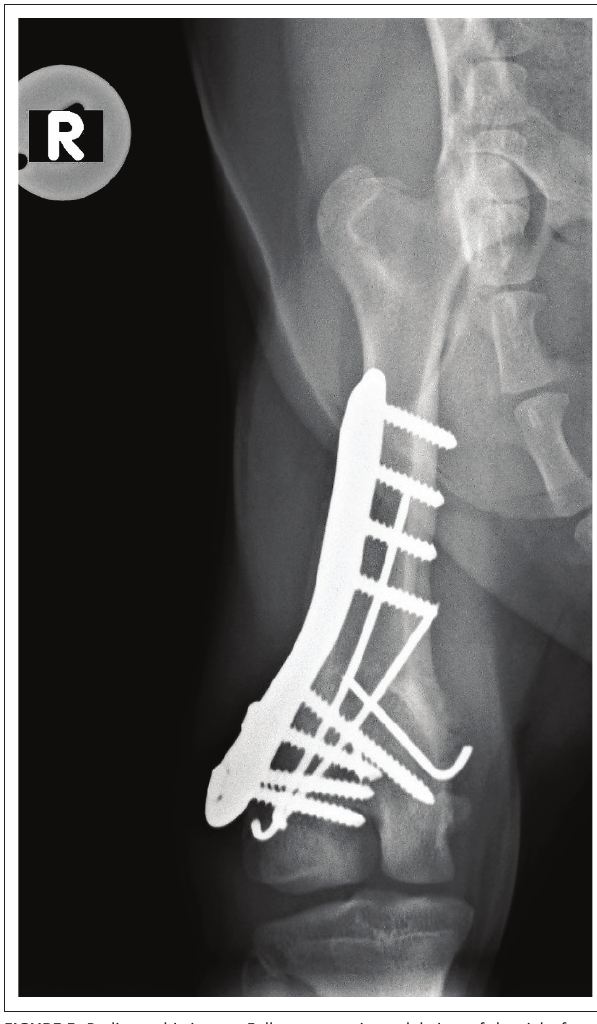
FIGURE 5: Radiographic image: Follow-up craniocaudal view of the right femur obtained 6 weeks